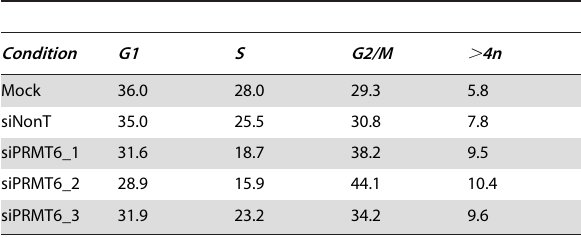
Table 1. Cell cycle distribution of control and siPRMT6 transfected U2OS